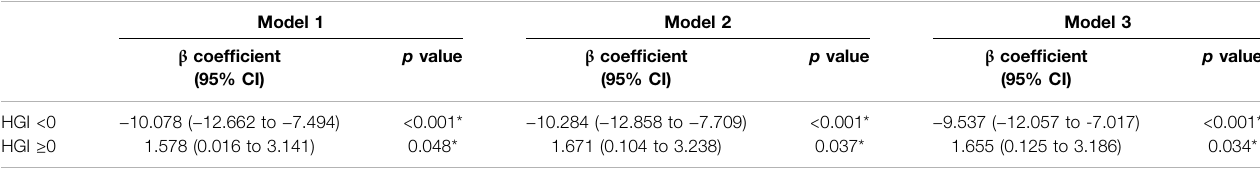
TABLE 2 | Linear regression analysis of the HGI with the proportion of SCr